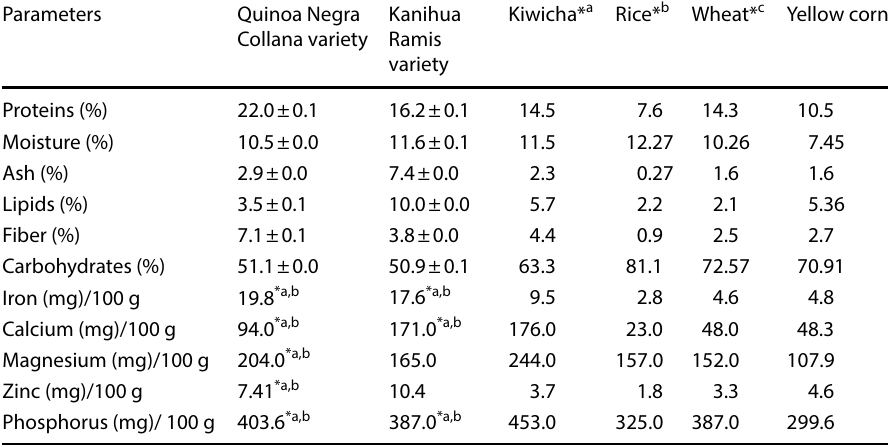
Data expressed on a dry weight